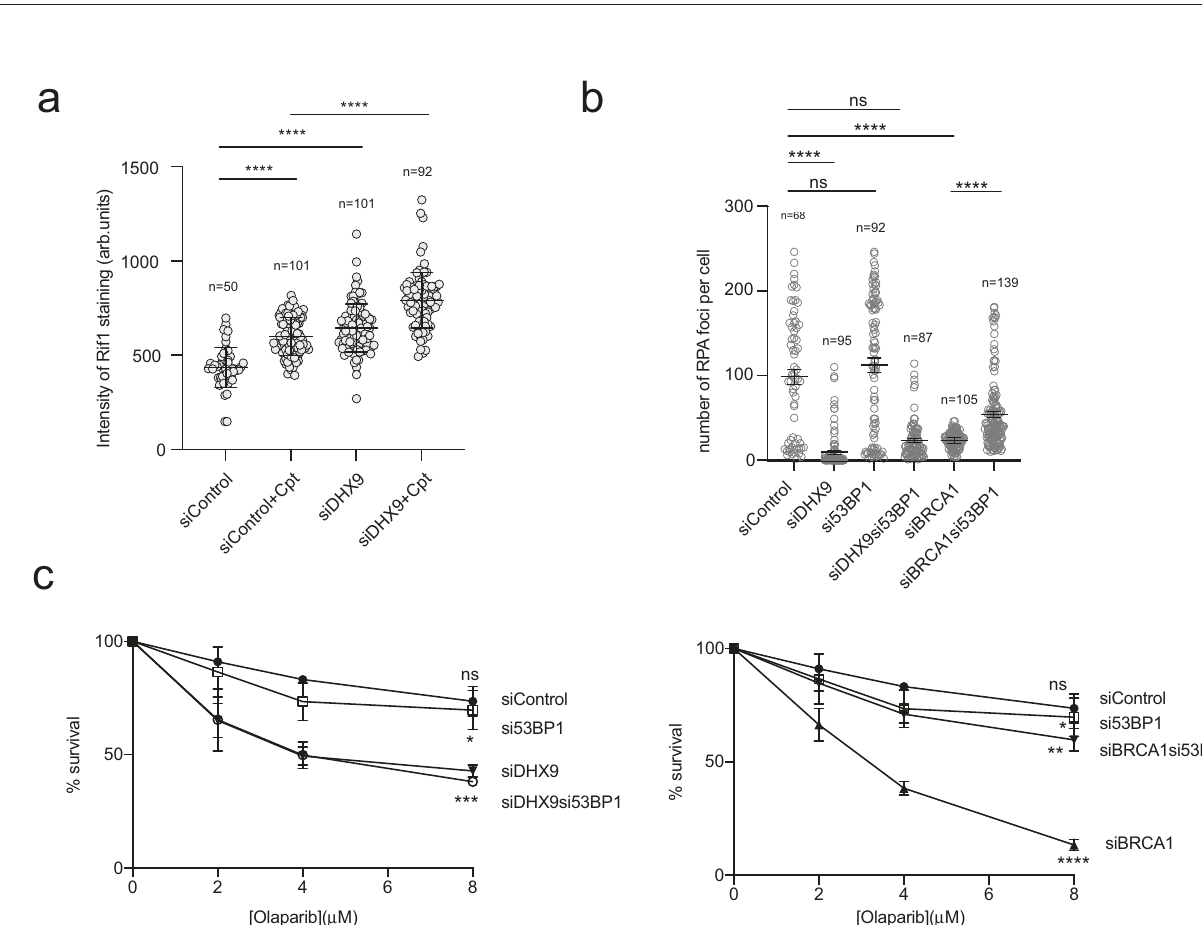
Fig. 7 BRCA1 and DHX9 form a complex that interacts with RNA Pol II-mediated through RNA. a Western blot showing co-immunoprecipitation of BRCA1 with DHX9 in cells treated with DNA damaging agents; 2 mM hydroxyurea (for 4 h), 2 μ M camptothecin (for 2 h), and ionizing radiation (10 Gy) (as indicated). All samples were treated with RNaseA to exclude interactions mediated by RNA. b Western blot of RNA Pol II immunoprecipitation from U2OS cells knocked down for speci fi c genes using siRNAs indicated and treated with 1 μ M camptothecin for 2 h (all samples). Blot shows co-puri fi cation of BRCA1 and DHX9 with RNA Pol II is dependent on the presence of both DHX9 and BRCA1 in cells. Co-precipitation of DHX9 and BRCA1 with RNA Pol II is also dependent on RNA as the interaction is disrupted in samples treated with RNaseA (indicated). c Fluorescence image (left panel) with quanti fi cation (right panel) showing that DNA damage-induced BRCA1 foci are diminished in cells knocked down for DHX9 and in cells treated with RNaseA. Graph (right panel) shows the quanti fi cation of n cells (as indicated) from three pooled biologically independent experiments. Mean values were shown to be signi fi cantly different using one-way ANOVA with post hoc Tukey ’ s test (**** p < 0.0001). Mean and standard deviation are shown. Source data are provided as a Source Data fi le.